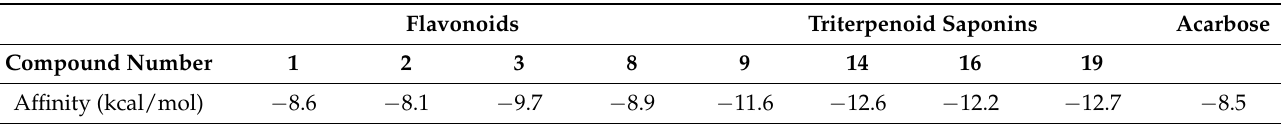
Table 5. Affinity values of major compounds with α -glucosidase.